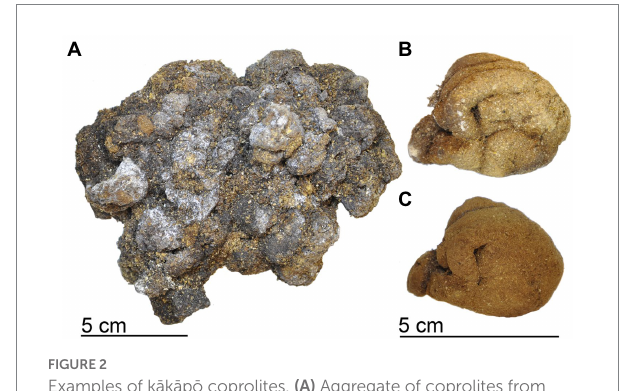
FIGURE 2 Examples of kākāpō coprolites. (A) Aggregate of coprolites from Mount Owen Cave, (B) Coprolite from Euphrates Cave system (sample X17/14/03). (C) Coprolite sample (X17/14/03) after exterior removal prior to